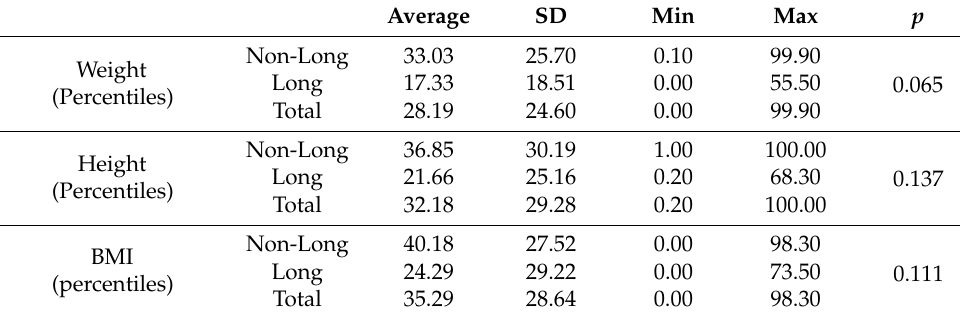
Table 2. Average auxological parameters.